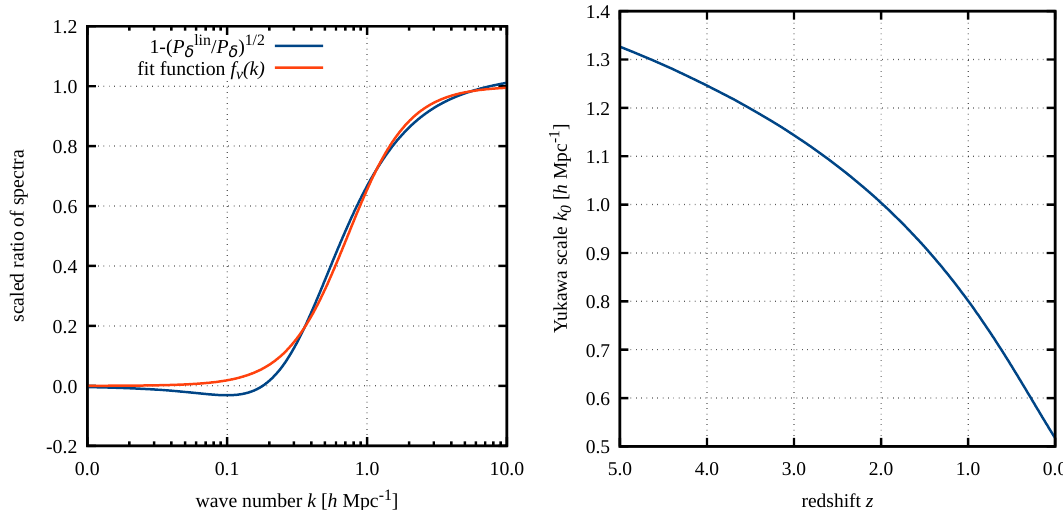
( lin ) / P ) 1 / 2 , scaled to unity at k (cid:29) 1, δ δ ( k ) from Eq. (13). The linear power spectrum was v as a function 0